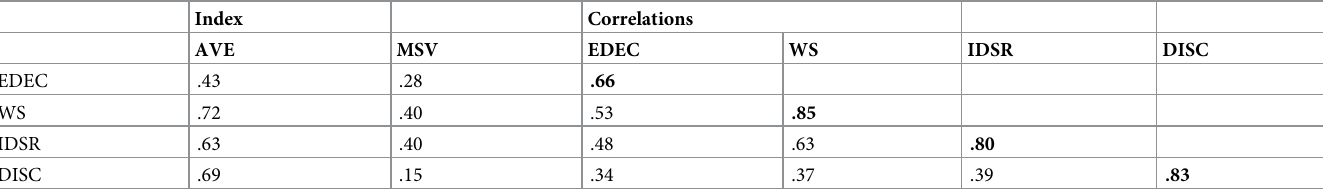
Table 4. Indices of reliability, convergent and discriminant validity for the four factors of IDS-15.